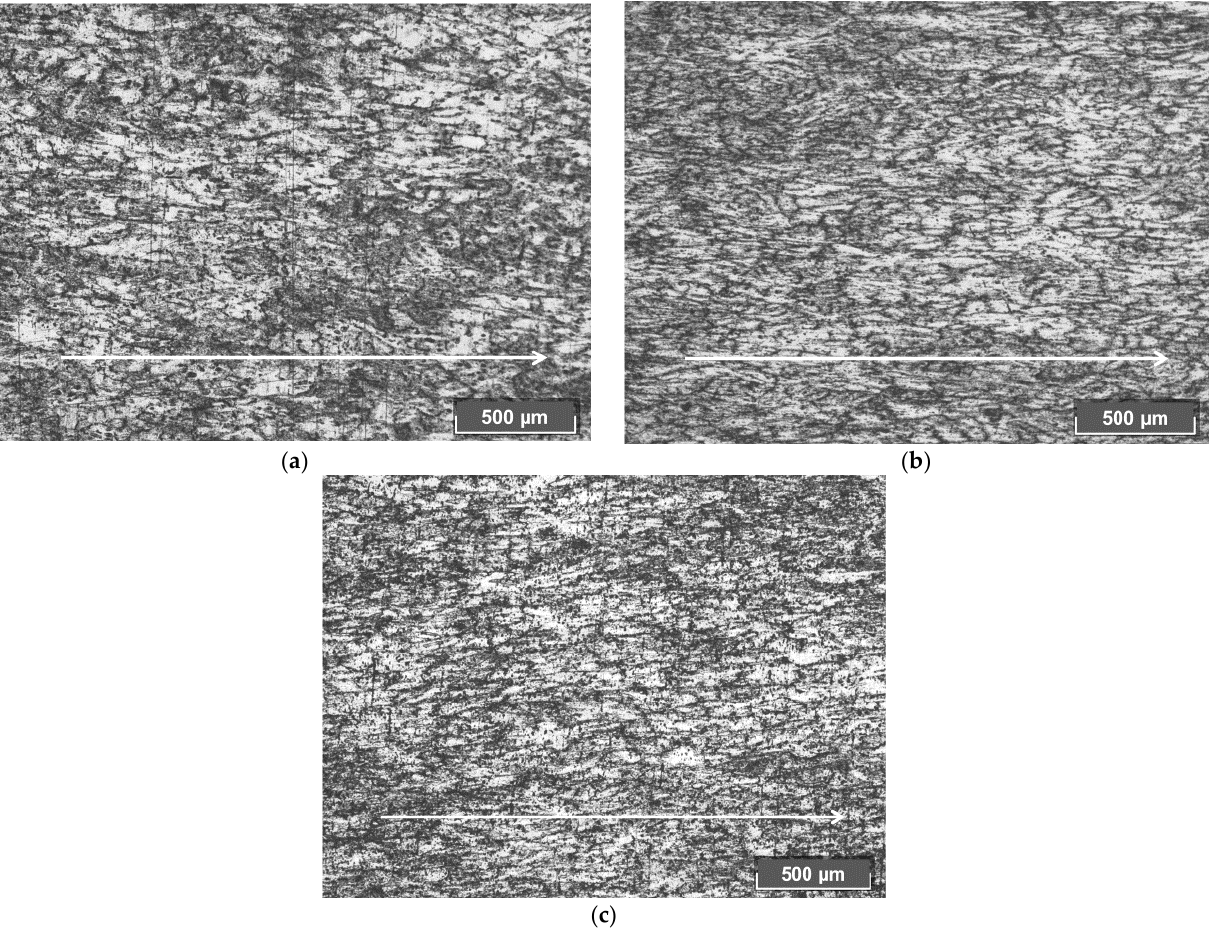
Figure 6. Hollow shell’s longitudinal section microstructure from the middle of the hollow shell’s wall after piercing by the entire plug ( a ), the plug with a cavity ( b ), and the hollow plug ( c ) (the arrows show the piercing direction).